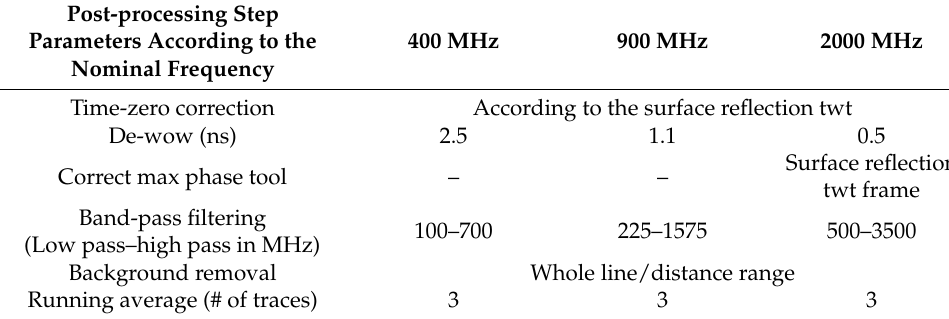
Figure 8. Data processing scheme for section P8U1 at stage 3 (before cleaning) in diagonal orientation of 2 GHz antenna: ( a ) raw GPR data, ( b ) dewow filter applied, ( c ) after move start time filter and after correct max phase applied, and ( d ) after band pass filter (Butterworth), background removal, gain, and running average processing steps. Table 6 present the post-processing parameters used for each nominal frequency of the antenna used in the surveys. Table 6. Post-processing parameters used for different frequencies.